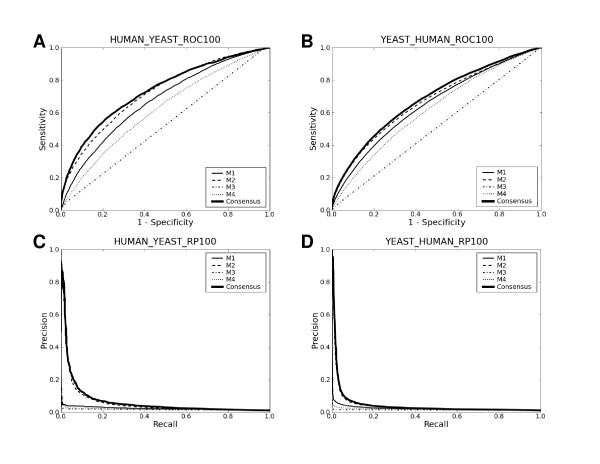
Cross-species benchmarking results. The title of each plot reads in the same way as in Fig. 1.